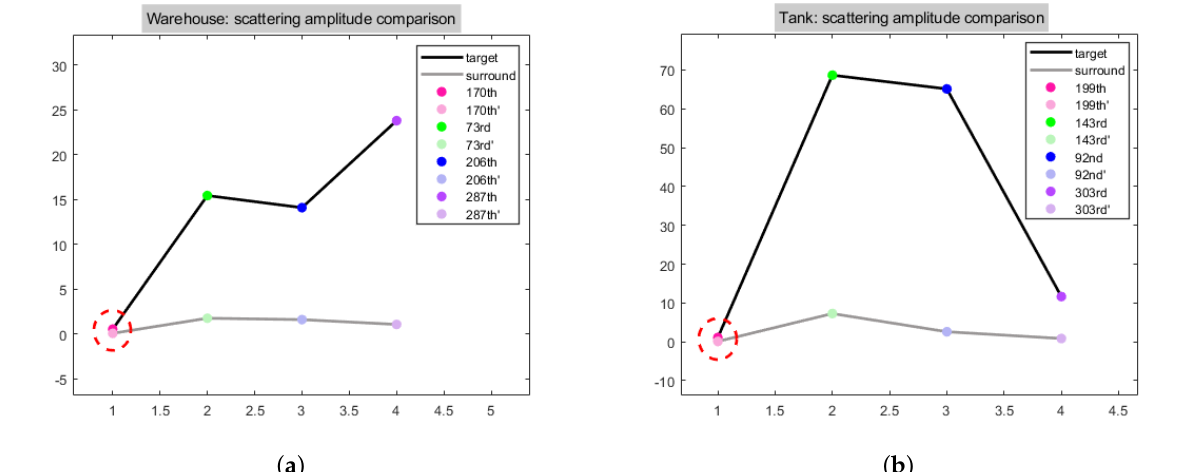
Figure 11. Comparison of scattering amplitude between target point and surrounding points: ( a ) Warehouse:170th, 73rd, 206th, 287th angle (’ represents surrounding point); ( b ) Tank:199th, 143rd, 92nd, 303rd angle. (The red circle represents the lowest value for difference between target point and surrounding